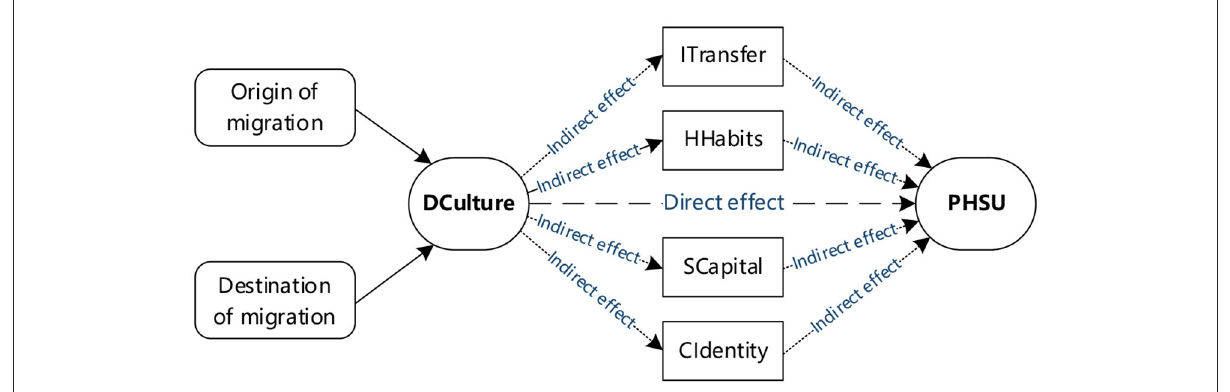
FIGURE1 Framework operationalized in the current